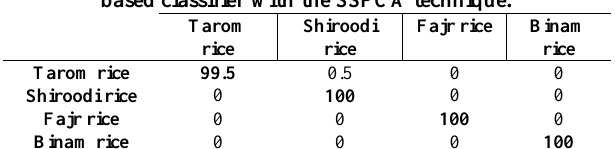
Table 7. Results of the relative confusion matrix based on the HOG feature for the proposed dictionary- based classifier with the SSPCA technique.